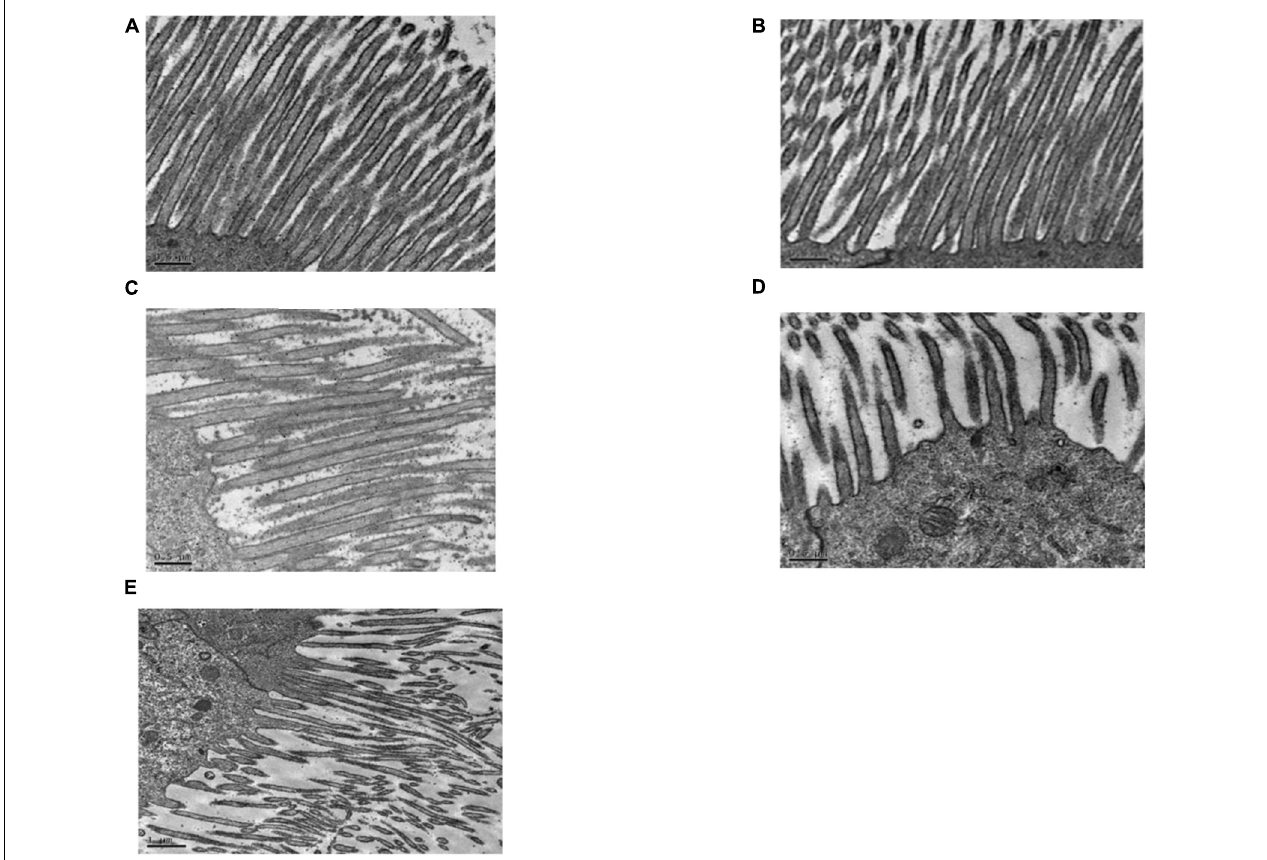
FIGURE 4 | Pathological effects of Sip1Ab and Cry8Ca on midgut microvilli of larvae of Colaphellus bowringi (A) Control group fed PBS for 3 days, (B) Cry8Ca treatment for 3 days, and (C–E) : 1, 2, and 3 days after treatment with Sip1Ab,